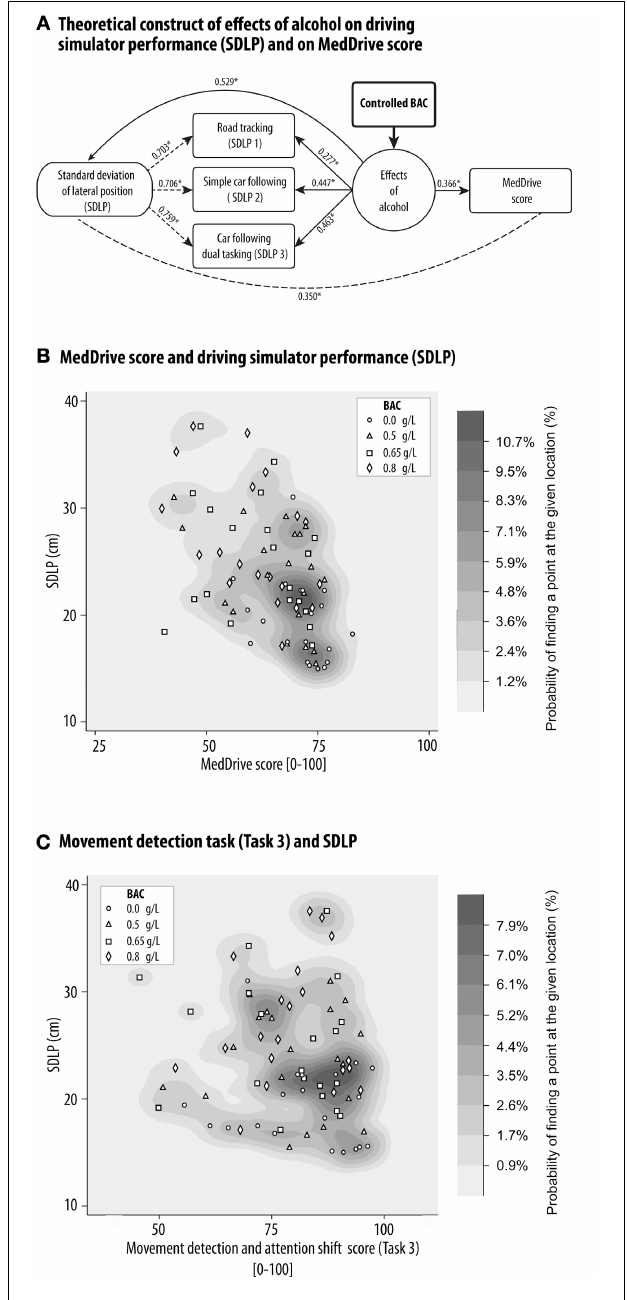
FIGURE 7 | MedDrive’s ability to model the effects of alcohol on driving simulator performance. Blood alcohol was controlled at four different concentrations in 20 young healthy drivers, and the effects of alcohol on the standard deviation of the lateral position during three driving simulator tasks was measured. (A) Schematic representation of causal links between alcohol, driving simulator performance, and MedDrive score. Numbers represent the ability of each link to model the effects of alcohol at an individual’s level ( R 2 ). ∗ p < 0.001. Dashed lines mean that we do not assume a causal relationship between measures. Density distribution plot of the correlation between SDLP and MedDrive score (B) or Movement detection task (C) . The oblique orientation of the distribution associated to the gradient of BACs illustrates the shared causal link of effects of